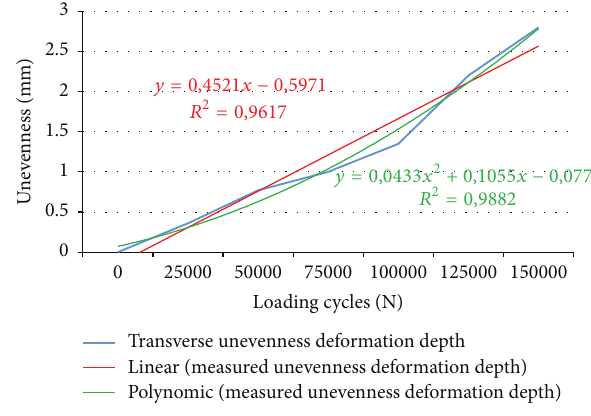
Figure 8: Transverse unevenness.